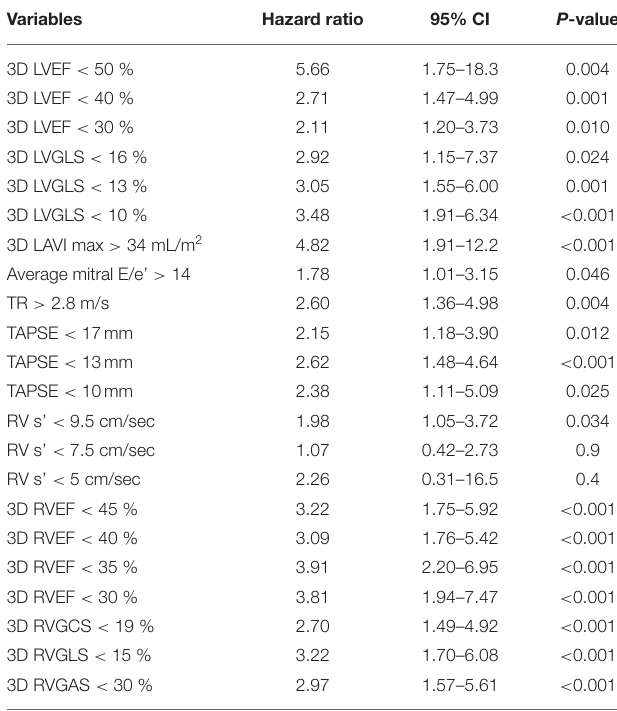
TABLE 3 | Univariate cox proportional hazards analysis with dichotomous variables for “cardiac death, sustained ventricular arrhythmia, or HF